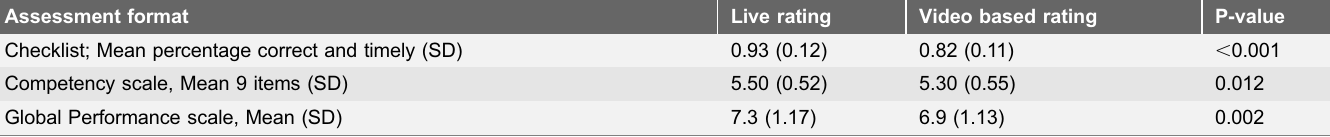
Table 2. Comparison video-based and live assessment results of 22 residents (case 1 and 4). Assessment